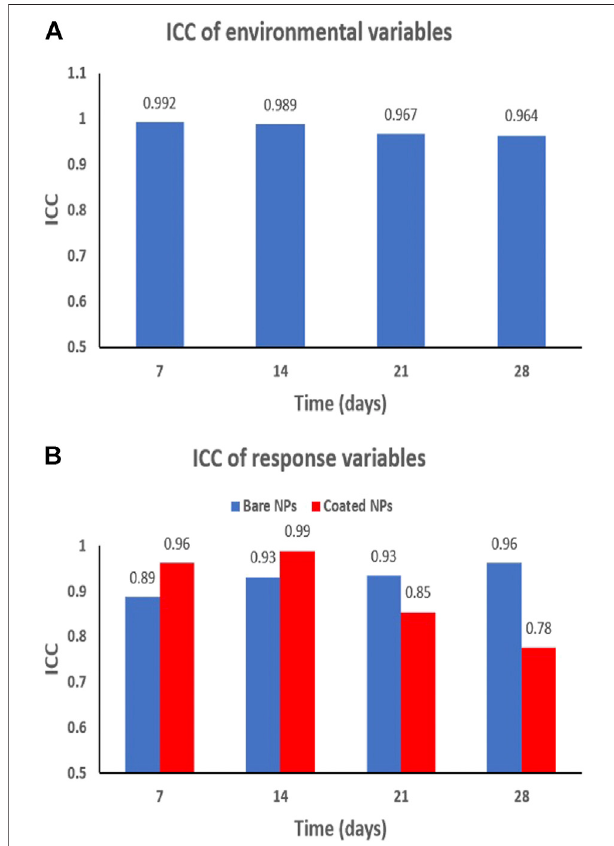
FIGURE 2 | (A) Intraclass correlation (ICC) obtained on the environmental variables (pH, temperature, dissolved O 2 , ORP, and conductivity) in all mesocosms either control or contaminated ones. (B) ICC values based on the measurements of response variables (Ce concentrations and biomarkers) obtained in mesocosms contaminated with bare CeO 2 NPs (blue) and coated CeO 2 NPs (red).